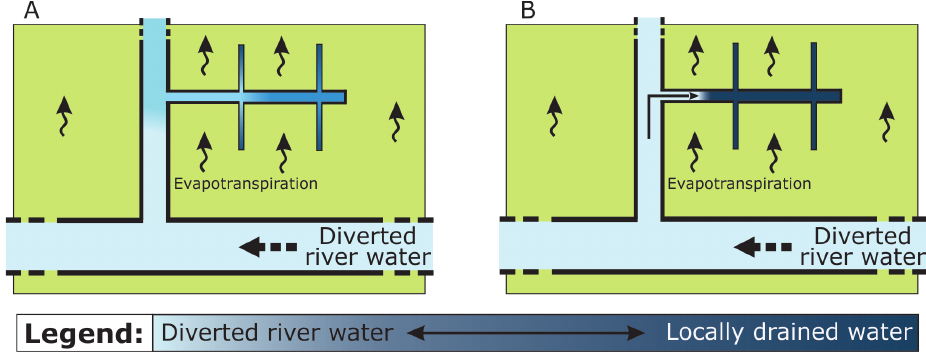
Fig. 5. Visualization of the two conceptual models of the spatial propagation of diverted river water into a polder system. The results of this study indicate that the diverted river water did not propagate up into the small headwater ditches as was expected (A) . Instead, the local drainage water is pushed back into the headwater ditches by the diverted river water (B)